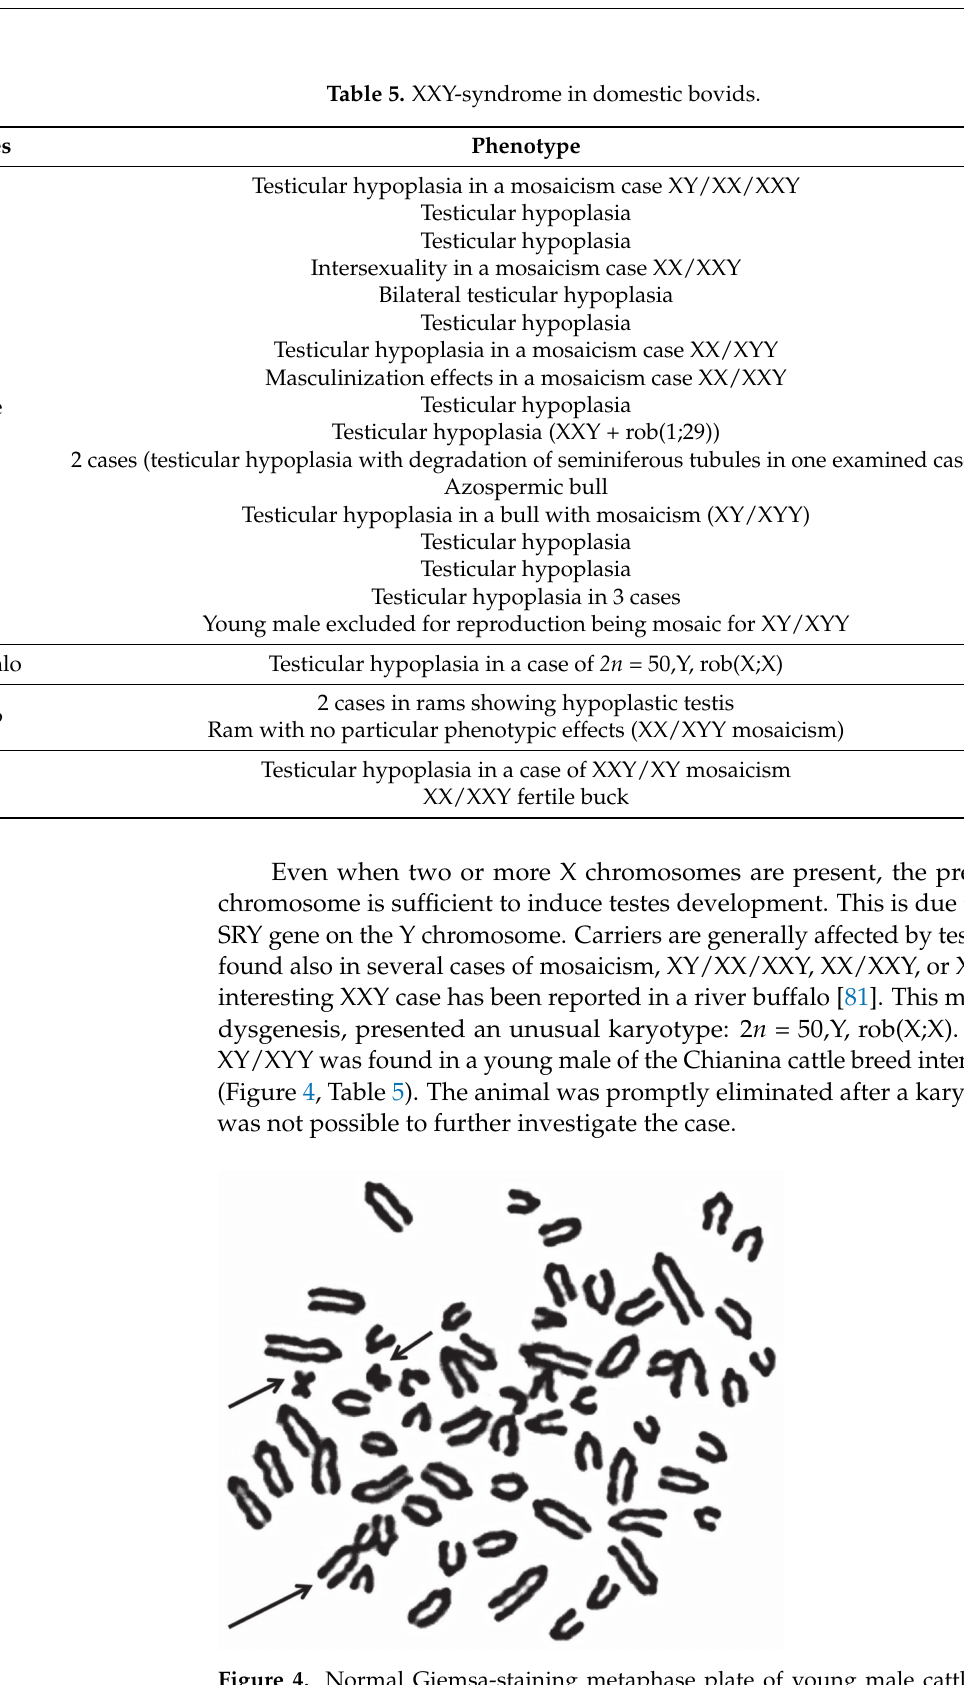
Figure 4. Normal Giemsa-staining metaphase plate of young male cattle for reproduction but promptly eliminated because it was found to be affected by XY/XYY mosaicism. The X chromosome (large arrow) and Y chromosomes (small arrows) are